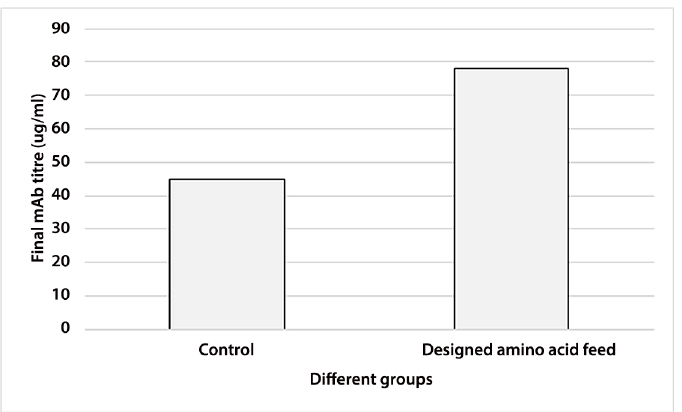
Fig 3. Comparison of final mAb titre in control and designed amino acid feed